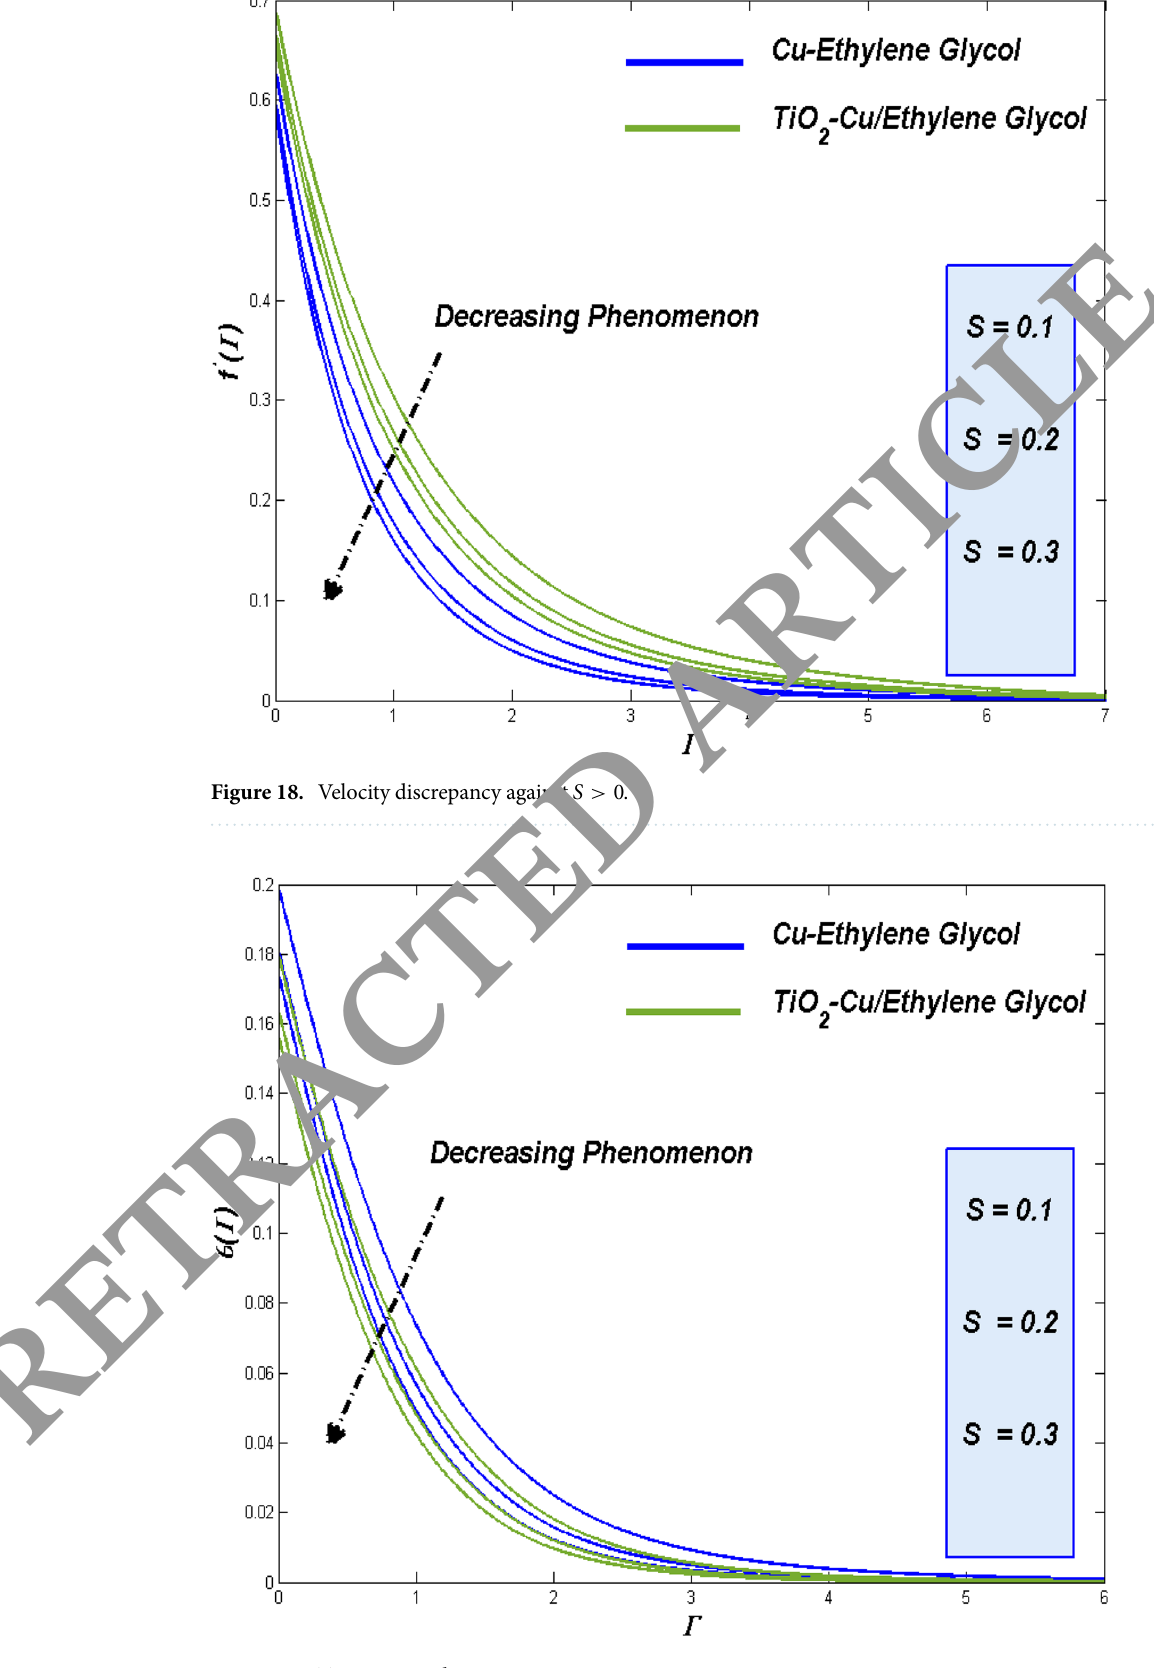
Figure 19. Temperature discrepancy against S > 0